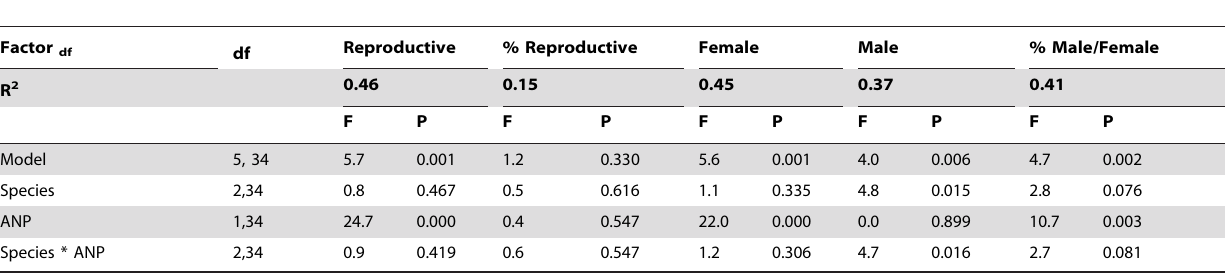
Table 2. GLMs of reproductive biomass, % reproductive biomass of ANP, female and male reproductive biomass, and % of male/ female allocation as a % of reproductive biomass, with as independent factors species and as a covariate, aboveground annual net productivity (ANP).